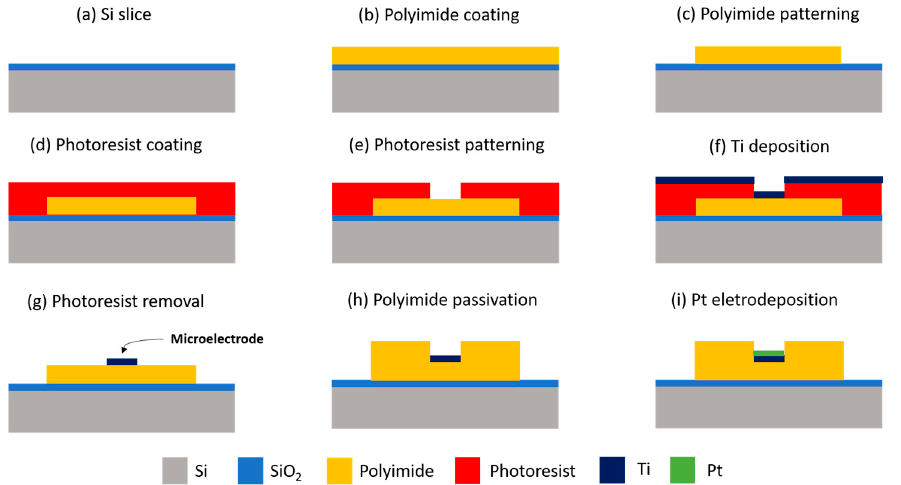
Figure 1. µMLA digital masks to pattern: ( a ) neural probe geometry; ( b ) neural probe contact pads, tracks and microelectrodes; ( c ) neural probe passivation.